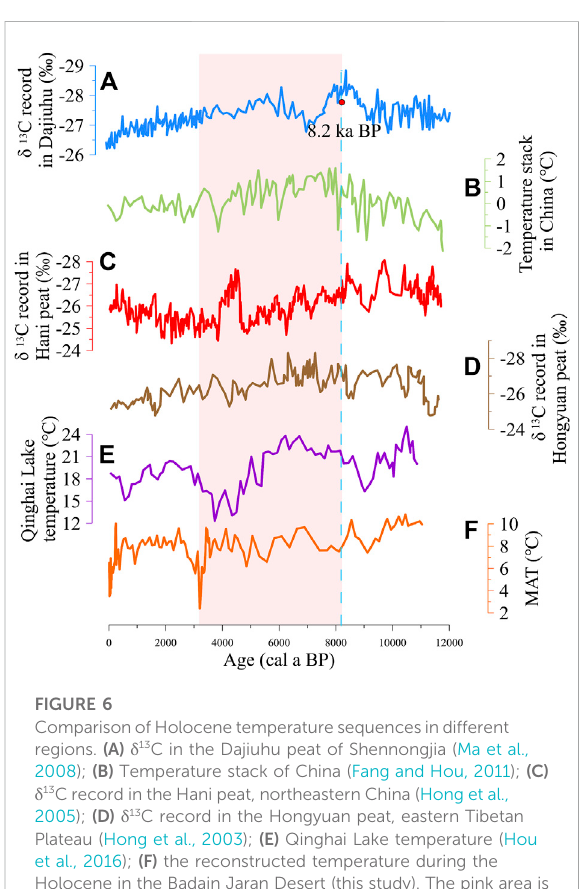
ComparisonofHolocenetemperaturesequencesindifferent regions. (A) δ 13 C in the Dajiuhu peat of Shennongjia (Ma et al., 2008); (B) Temperature stack of China (Fang and Hou, 2011); (C) δ 13 C record in the Hani peat, northeastern China (Hong et al., 2005); (D) δ 13 C record in the Hongyuan peat, eastern Tibetan Plateau (Hong et al., 2003); (E) Qinghai Lake temperature (Hou et al., 2016); (F) the reconstructed temperature during the Holocene in the Badain Jaran Desert (this study). The pink area is the Holocene ‘ megathermal ’ . The red circle and the dotted blue line represent the cold event at 8.2 ka BP.